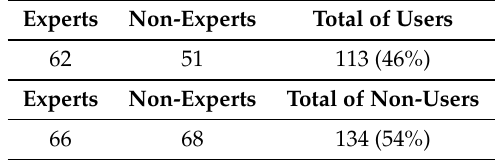
Table 18. Numbers of Users and Non-users of Password Managers, including experts and non-experts.